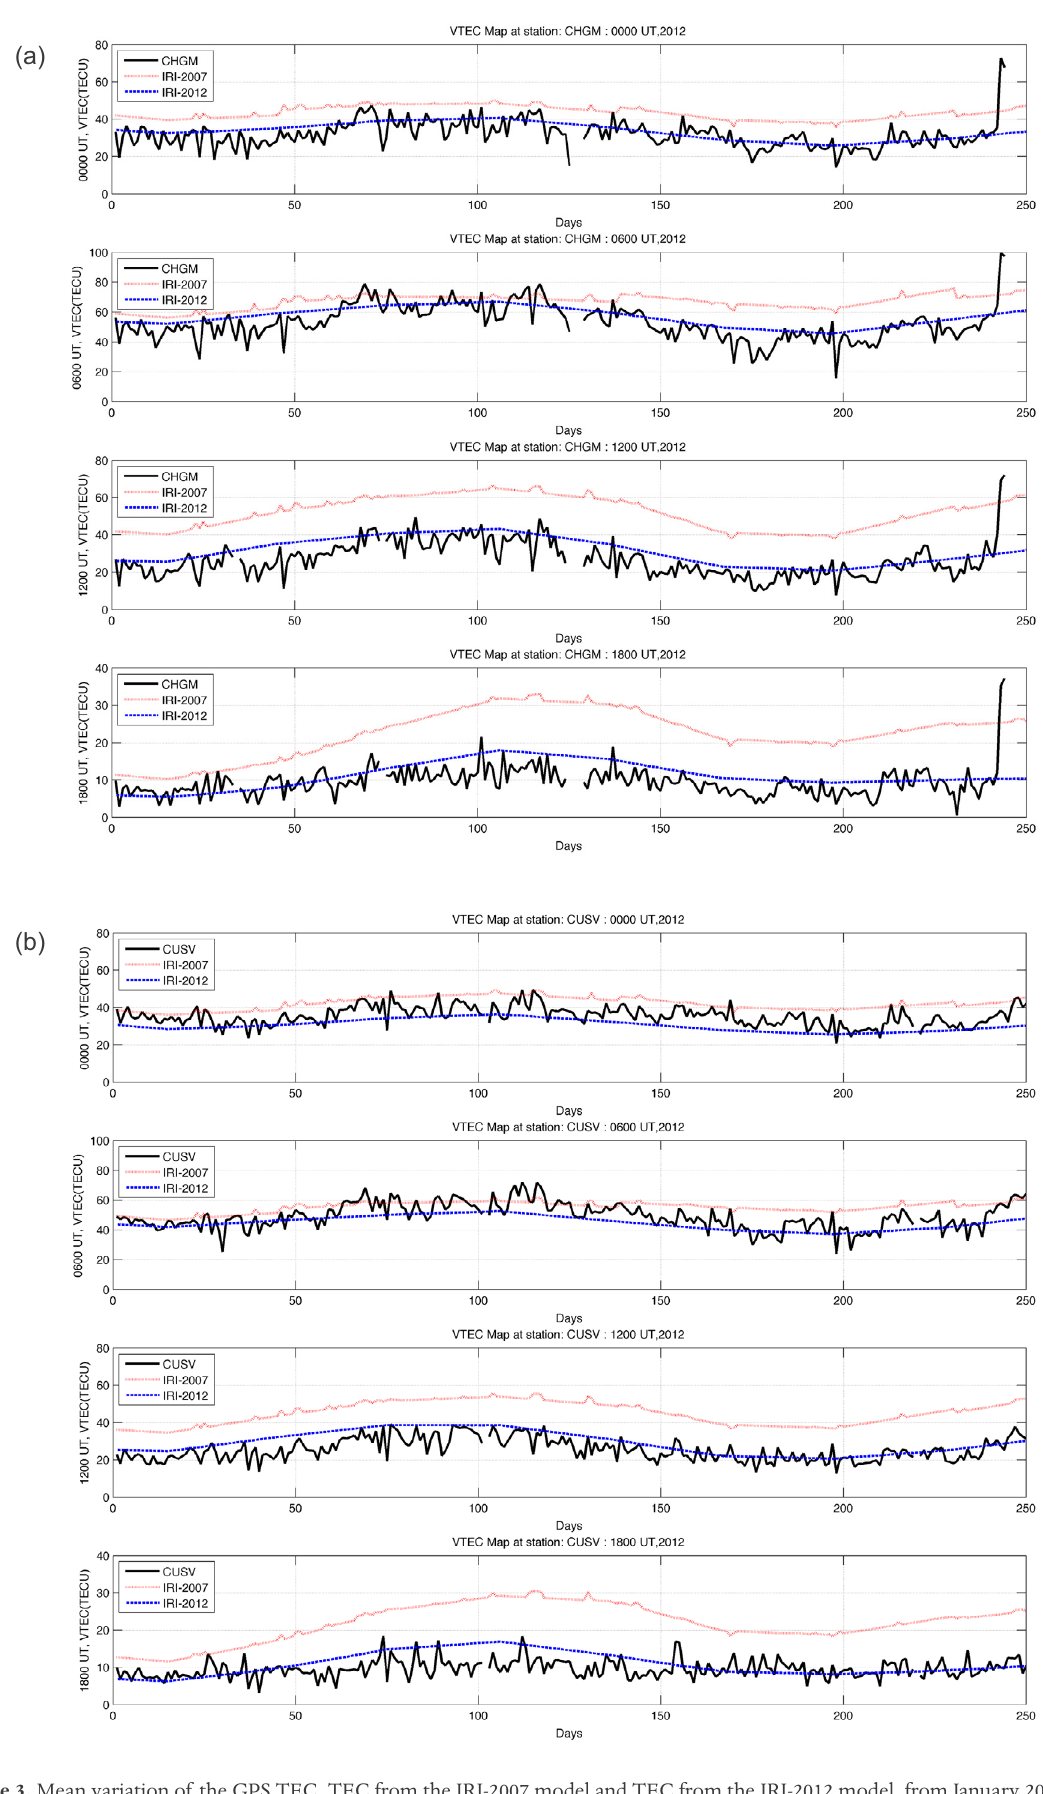
Figure 3. Mean variation of the GPS TEC, TEC from the IRI-2007 model and TEC from the IRI-2012 model, from January 2012 to August 2012 at CHGM and CUSV respectively sunrise, midday, post sunset and